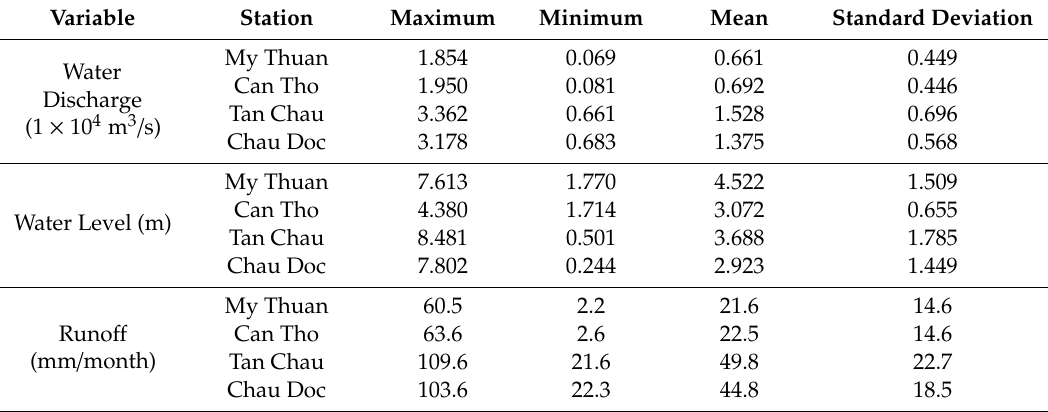
Figure 2. Water level and runoff rating curves for the four selected hydrological stations in the Mekong River Delta. Table 1. Water discharge (1 × 10 4 m 3 /s), water level (m), and runoff (mm/month) maxima, minima, means, and standard deviations for the four selected Mekong River Delta hydrological stations.